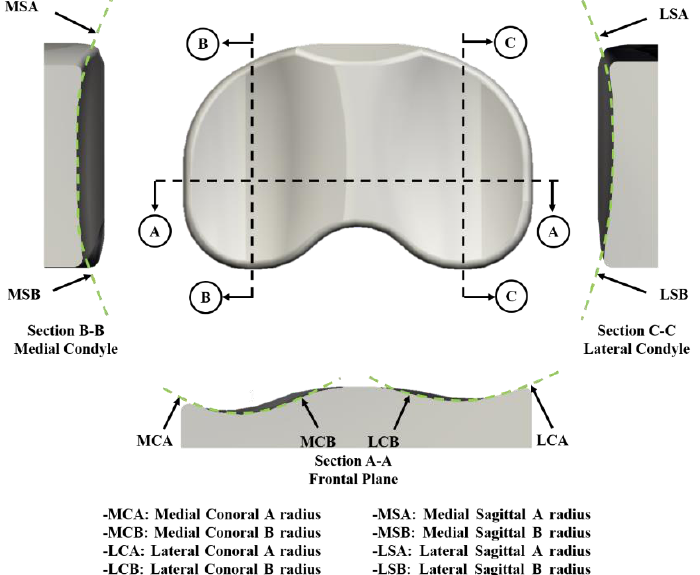
Figure 2. Design variables for the parametric model of tibial insert component.